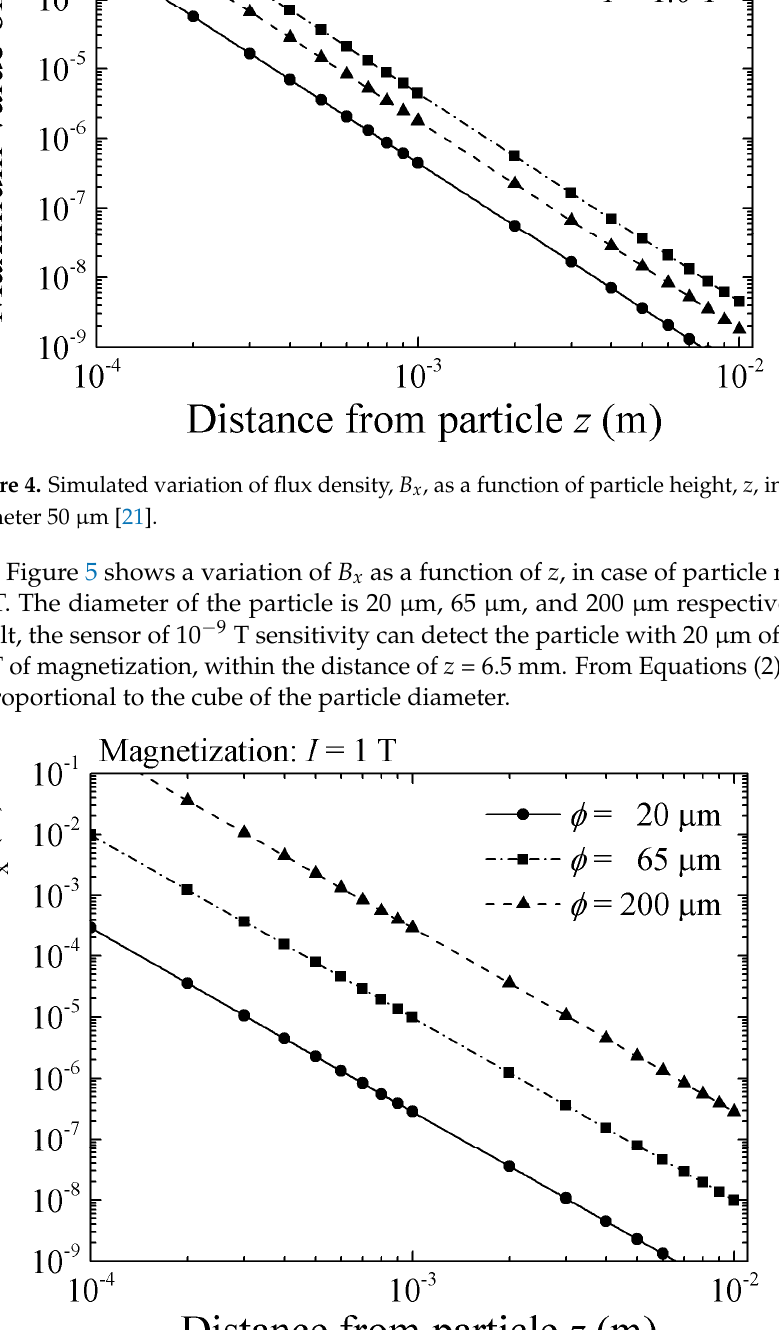
Figure 5. Simulated variation of flux density, Bx, as a function of particle height, z, in case of particle magnetization 1.0 T [21]. These results show, in order to detect a tens of micrometer magnetic particle by a sensitive sensor, the particle must be magnetized almost saturation, that is why applica- tion of strong normal field is needed, and placed it in the vicinity of the sensor. 2.2. Case of a Magnetized Particle Running in the Vicinity of Sensor Element The previous subsection described a case in which the magnetic field at the sensor position was uniform and independent of sensor element position. This situation arises when the distance between the sensor and the magnetized particle is large enough. In this subsection, a discussion is made for the case when a magnetized particle is running in the vicinity of sensor element. Figure 6 explains an interaction between the magnetized particle and thin film sensor in a vertical magnetic field. The magnetic particle is magnetized in the vertical direction just above the sensor element, and the generated field affected the sensor output caused by a positional changing magnetic field. An effect of a distributed magnetic field on a sensor impedance is formulated as follows;